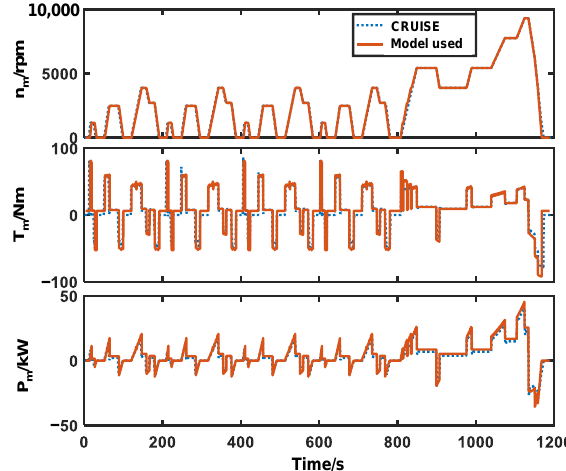
Figure 11. Energy consumption model simulation